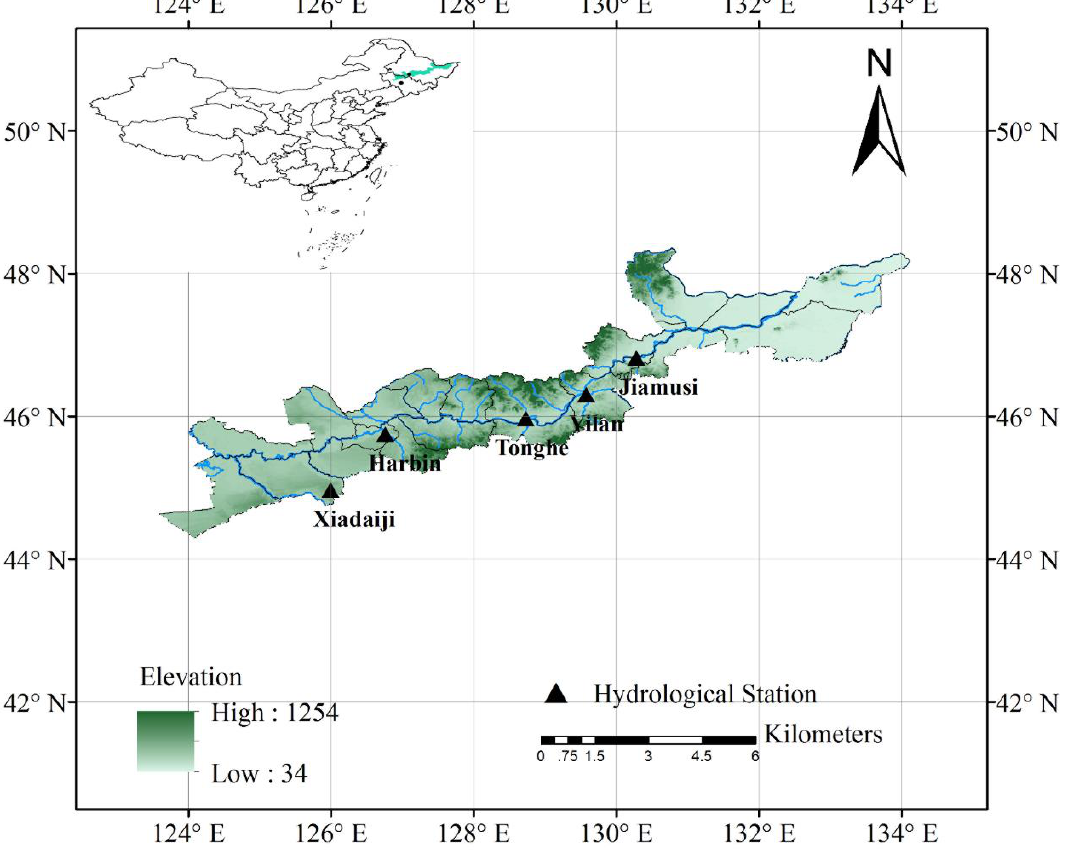
Figure 1. Geographical location of the study area and the locations of hydrological stations.